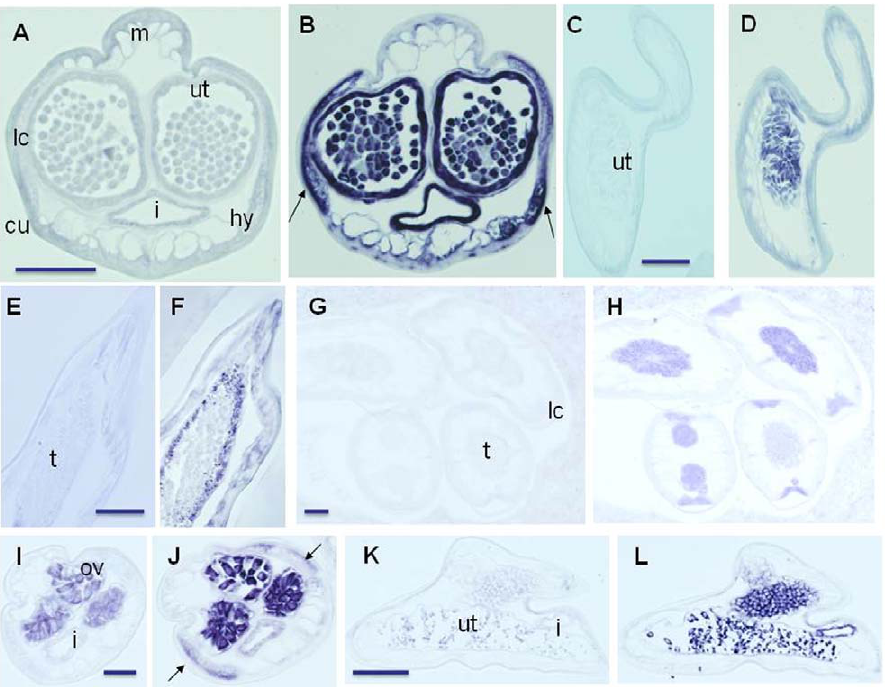
Figure 3. Insitu hybridization of adult filarial worms. A–H are stained with probes made from an O. flexuosa sequence with homology to Wolbachia 2- methylthioadenine synthase (2-MAS, wOf53). A, C, E and G are stained with the sense probe (negative control), while B, D, F and H show matching consecutive sections stained with the antisense probes. 2-MAS probe labels lateral cords, intrauterine stretched microfilaria and uterine and intestinal epithelium of female B. malayi (B), the oocytes and uterus of female A. viteae (D), the spermatogonia in the periphery of the testes of male A. viteae (F), and lateral chords and different stages of sperm development in the testes of male O. flexuosa (H). I–L are stained with probes made from an O. flexuosa sequence with homology to Wolbachia DNA polymerase I (pol I, wOf88). I and K are stained with sense probes (negative control) while H and L are the matching consecutive sections stained with antisense probes. pol I probe labels ovaries and granular structures resembling Wolbachia (arrows) in the lateral chords of female B. malayi (J) and oocytes in female A. viteae (L). Abbreviations: m, musculature; i, intestine; lc, lateral chord; cu, cuticle; hy, hypodermis; t, testes; ut, uterus; ov, ovary. Scale bar 40 m m.